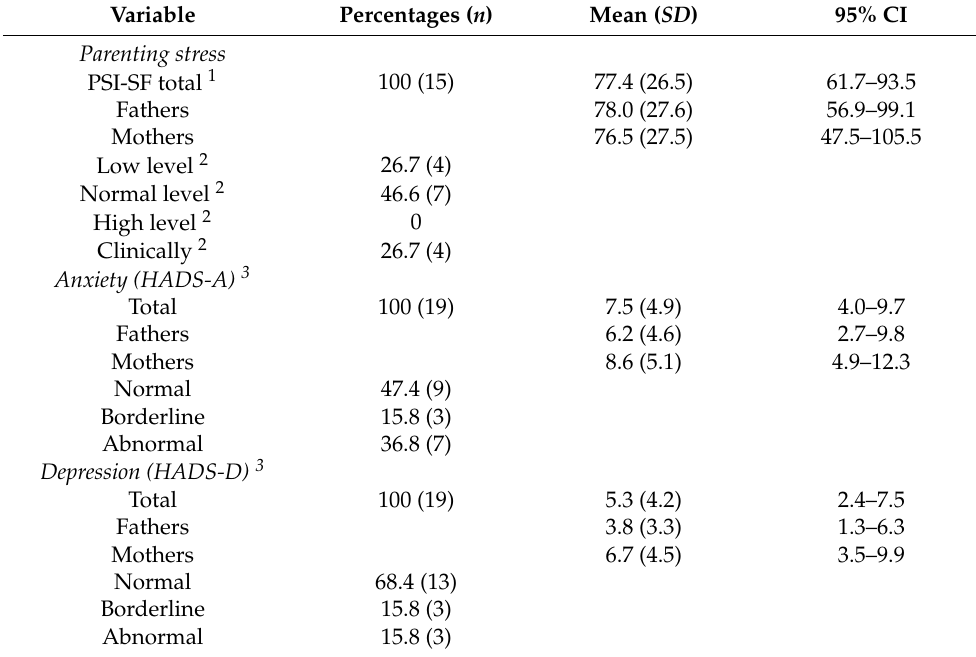
Table 2. Percent and mean scores of the Parenting Stress Index-Short Form third edition (PSI-SF) and the Hospital Anxiety and Depression Scale (HADS) for the group and for the mothers and fathers. Variable Mean ( SD ) Parenting